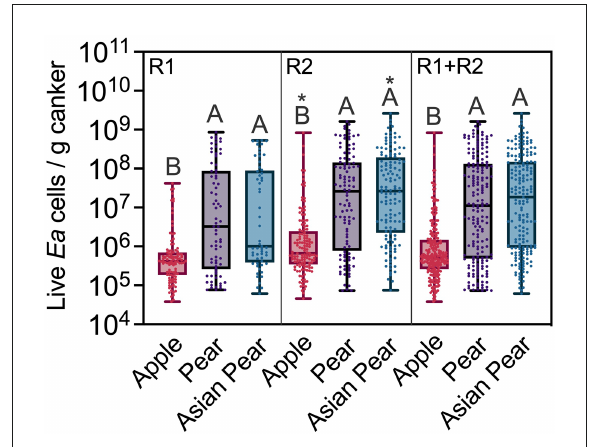
FIGURE 4 Erwinia amylovora live cell concentrations in cankers on apple, pear, and Asian pear, in an experiment repeated twice. Median values, interquartile ranges and full ranges of live E. amylovora cell concentration data are represented with box and whisker diagrams. Dots indicate concentration values for individual positive cankers for E. amylovora detection. The data sets labeled as apple, pear and Asian pear include data from all the cultivars belonging to the same host species. Different capital letters indicate significant differences between E. amylovora cell concentrations in apple, pear, and Asian pear cankers, assessed by Kruskal-Wallis ANOVA followed by Dunn’s multiple comparisons tests. All the trees used for these comparisons were non-irrigated. Asterisks denote significant differences between the datasets in the second experimental repeat (R2) and the same ones assessed during the first experimental repeat (R1). R1 + R2, combined data from R1 and